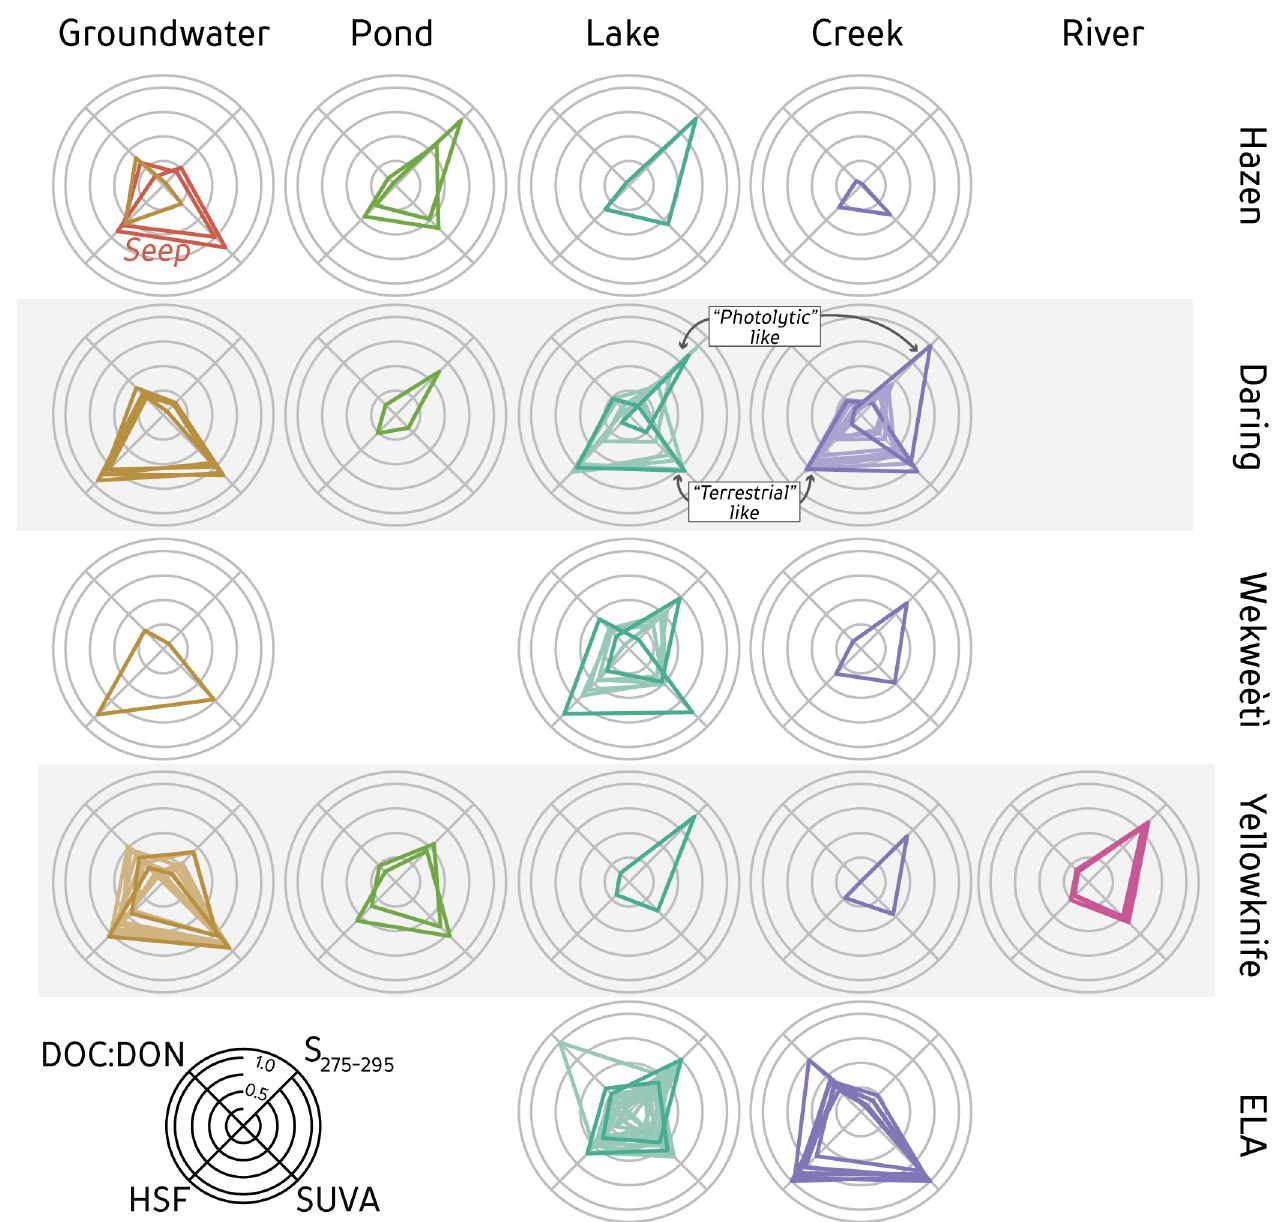
Fig 4. Composition Wheels for DOM from different hydrologic settings within each geographical site. Axes are a numerical value normalized relative to the maximum and minimum encountered within the dataset for each parameter. Parameters for each axis found in bottom left. The orientation of the composition wheel (CW) axes are arbitrary. Different samples from the same hydrological and geographic setting are plotted within the same CW. Two ‘end member’ compositions are highlighted in sites with many samples to help visualize the continuum of DOM mixtures: groundwater-like DOM (low DOC: DON, high SUVA and HSF) or photolyzed DOM (high S 275-295